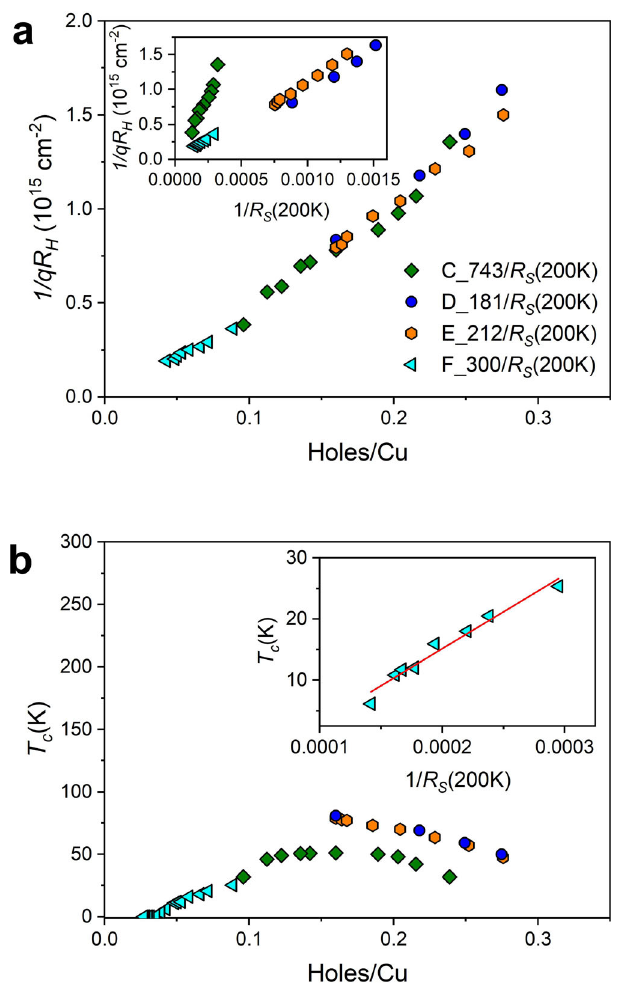
Fig. 2 Hall coef fi cient and inverse sheet resistance for estimating doping. a Dependence of 1/ qR H on p = S / R S ( T f ) for device F of this work and devices C, D, and E of our earlier works. Inset: Dependence of 1/ qR H on 1/ R S (200 K) showing linear behavior. b Superconducting dome as a function of T c and of doping p as calculated above for devices C, D, E, and F. Inset: Critical temperature T c as a function of 1/ R S (200 K) showing a linear dependence in the neighborhood of zero T c